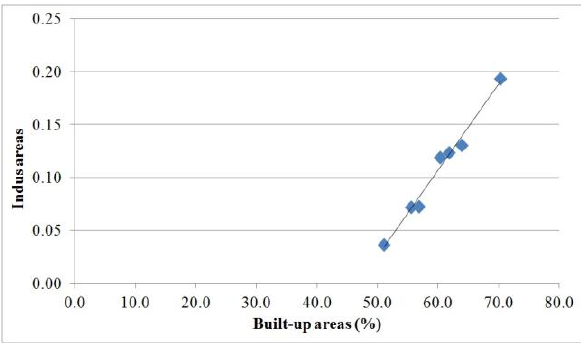
Figure 5. Relationship between the percentage of built-up areas and the industrial areas for 2005 ( R 2 =